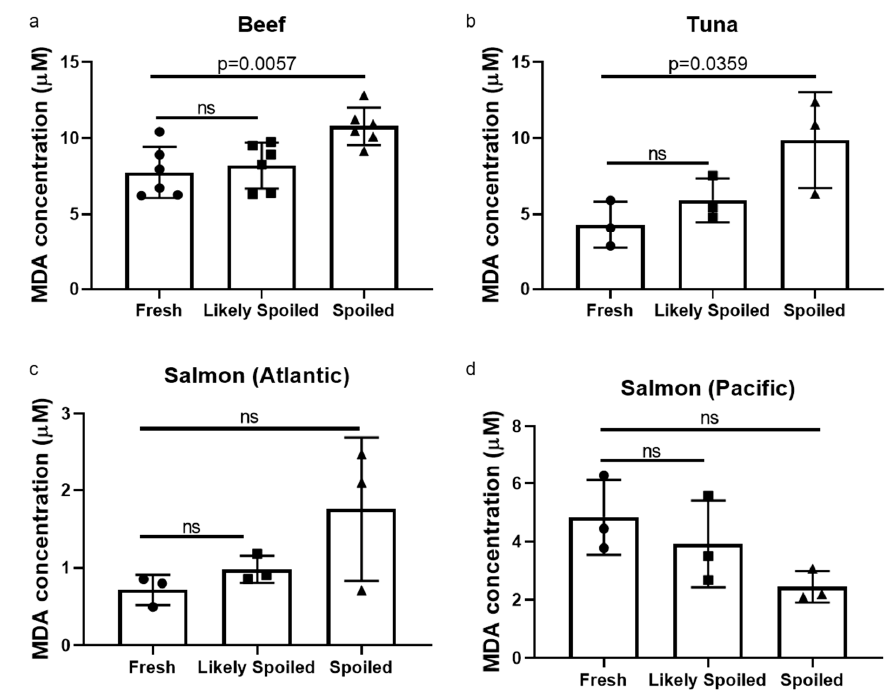
Figure 4. Thiobarbituric acid reacted substance (TBARS) assay to evaluate food freshness (ns: not significant).